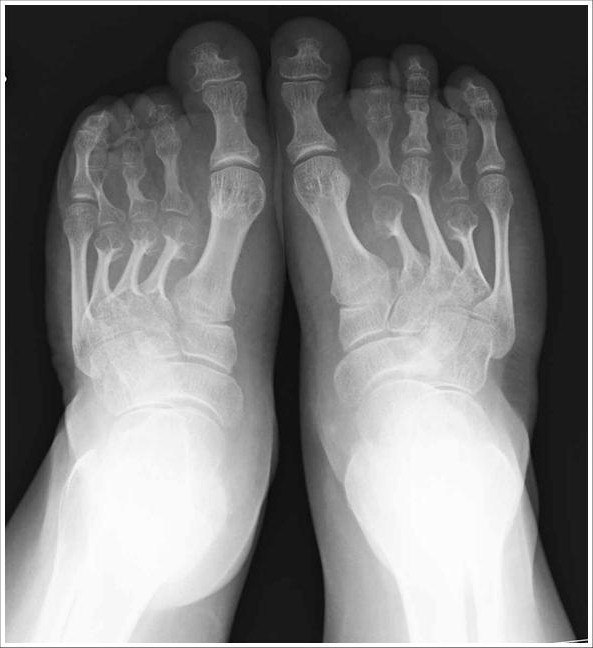
Radiographs of feet. Note the 2nd and 4th metatarsal bones and the great toe.